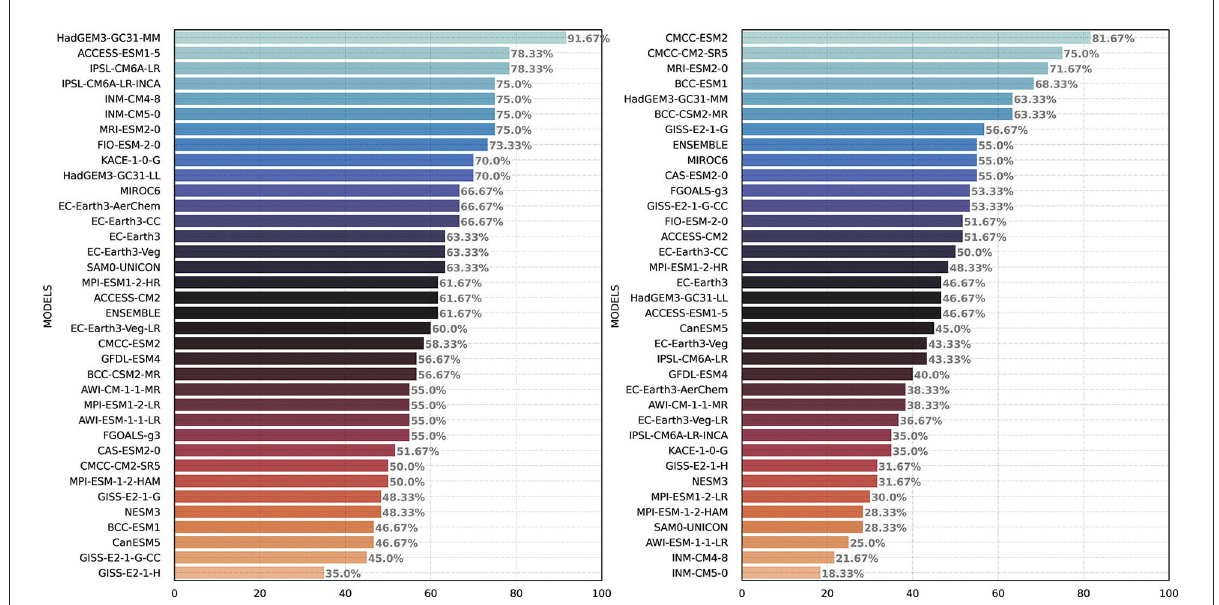
FIGURE13 Ranking of CMIP6 models based on the skill of the models simulates the precipitation (left) and temperature (right) annual cycle for the historical period (1995–2014) over five-study regions. The values correspond to the percentage of hits (hit score) based on Figure 11 (precipitation) and Figure 12 (temperature).